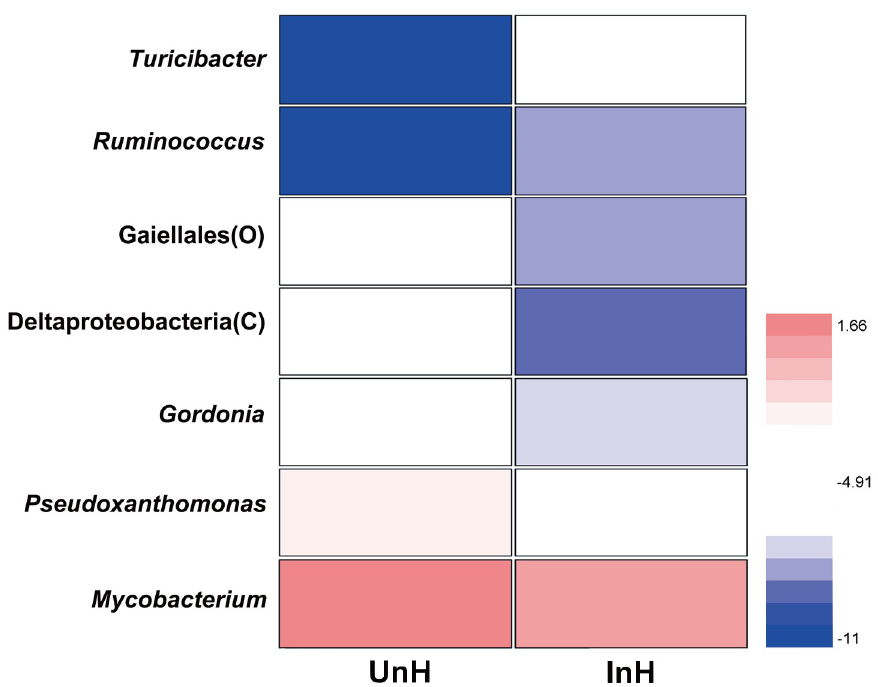
Fig 7. Heatmap of the significant taxa in the hindgut of grass carp. UnH, uninfected with S . acheilognathi in the hindgut of grass carp; InH, infected with S . acheilognathi in the hindgut of grass carp.